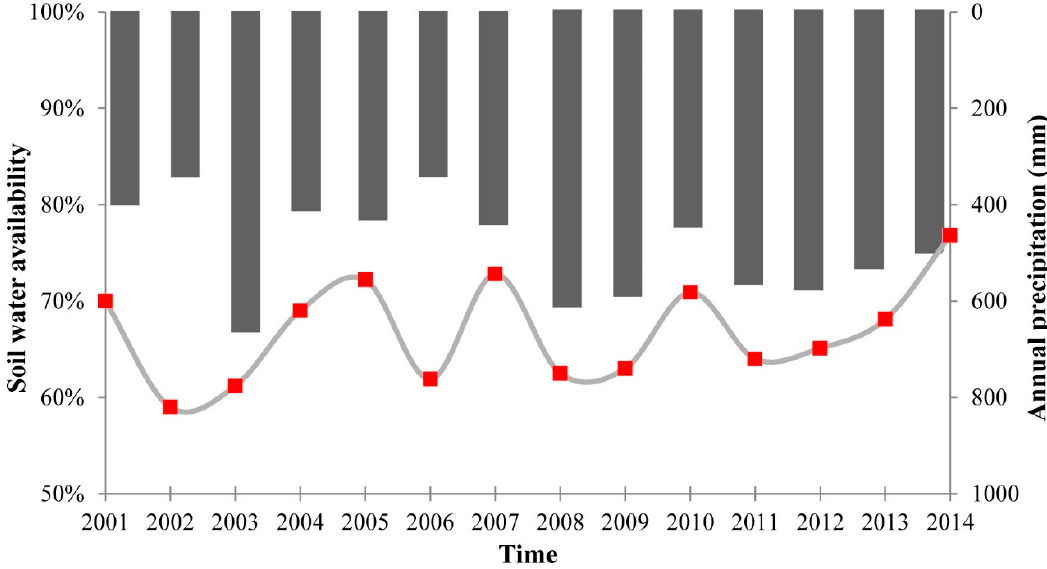
Figure 5. Comprehensive soil water availability in the simulation period.